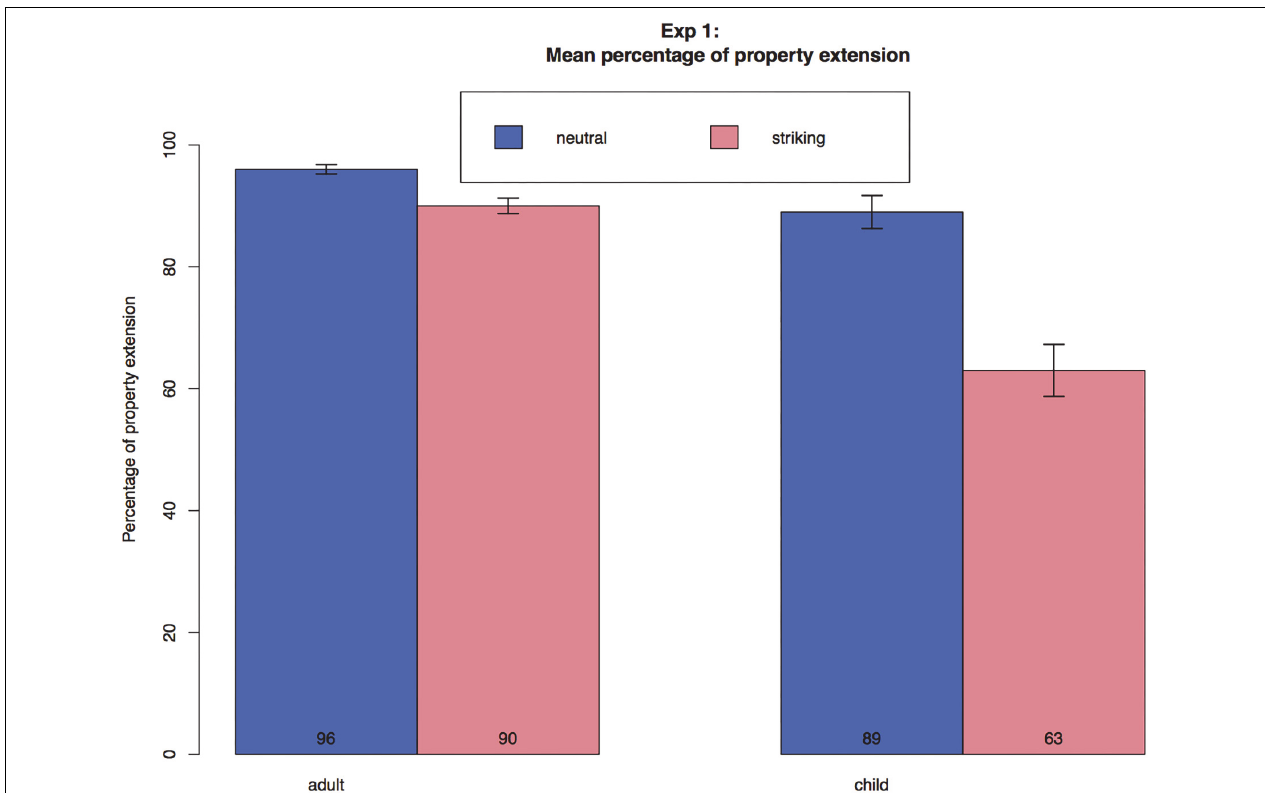
FIGURE 2 | Mean percentage of property extension across conditions in Experiment 1. Error bars represent standard error.